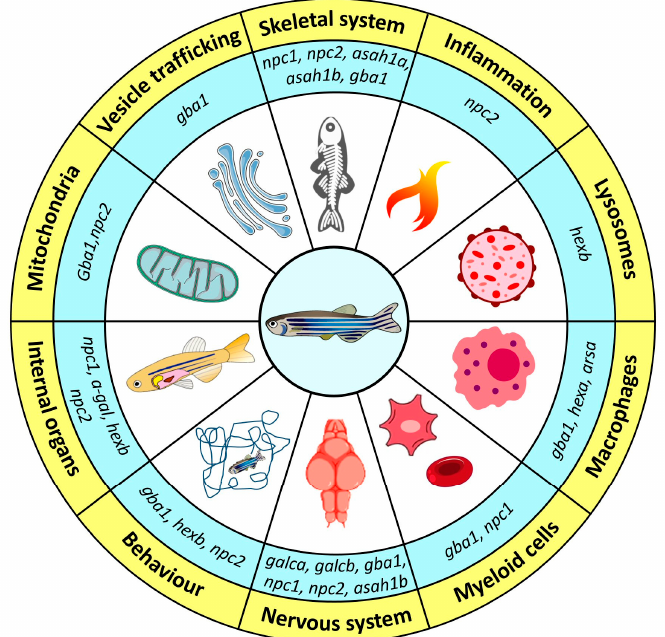
Figure 5. Main phenotypic alterations in zebrafish models of sphingolipidoses. Schematic summary of the major biological systems affected in zebrafish embryos or adults following the knockdown or knockout of the indicated genes encoding for different sphingolipid metabolizing enzymes. See text for details.